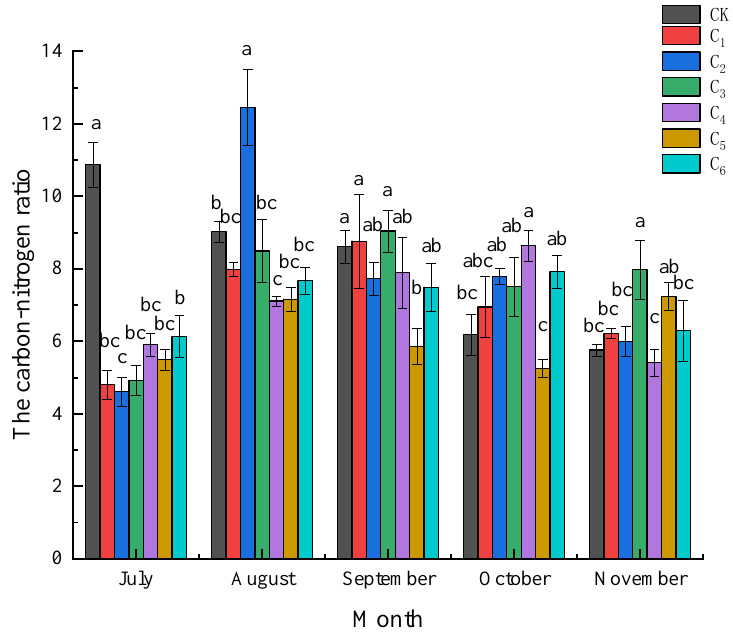
Figure 3. The carbon-nitrogen ratio in the roots of S. sebiferum container seedlings with different biochar treatments. Lowercase letters represent significance at 0.05 level and the same letter indicates no significant difference in full text.